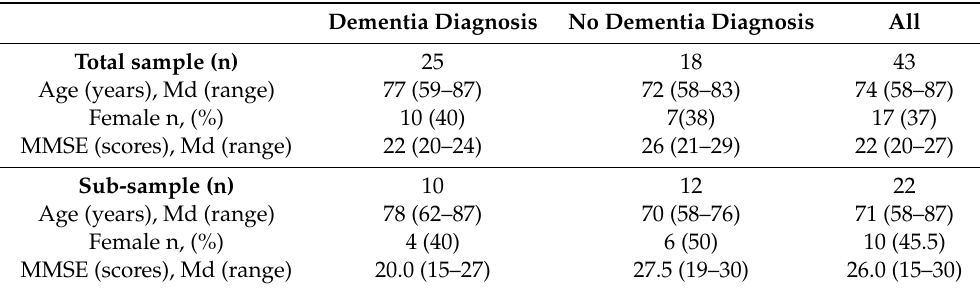
Table 1. Overview of the total study sample (n = 43) and the sub-sample (n =